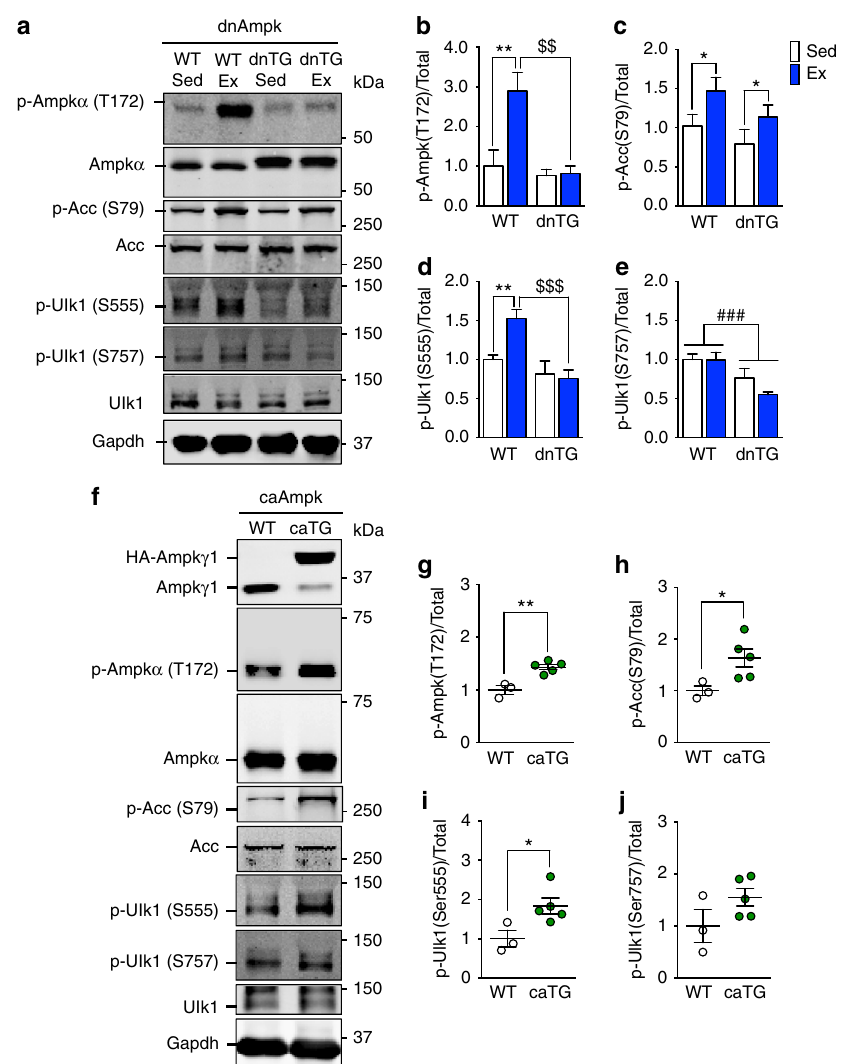
Fig. 3 Ampk is necessary and suf fi cient for phosphorylation of Ulk1 at Ser555 in response to acute exercise. Phosphorylation of Ampk at T172 in response to acute exercise is blocked in Ampk dnTG a , b , whereas increased phosphorylation of Acc at Ser79 post-exercise is still observed a , c . In Ampk caTG mice, both T172 Ampk and S79 Acc are elevated in sedentary conditions f – h . Phosphorylation of Ulk1 at Ser555 is blunted in dnTG skeletal muscle immediately after acute exercise a , d but elevated in caTG mice basally f , i . There was no effect on S757 phosphorylation in either dnTG mice post exercise a , e or sedentary caTG mice ( f , j ). Representative western blots are shown for dnTG mice a and caTG mice f . See also Supplementary Figs. 8 and 9. All quanti fi cation is presented as protein phosphorylation to total protein abundance ratio b – e , g – j . Data are presented as mean ± standard error of the mean. For dnTG study n = 10 WT or 5 – 7 dnTG (12 – 13 weeks). Results of two-way ANOVAs are * p < 0.05, ** p < 0.01 for sedentary vs. exercise comparisons, F = 4.57 and DF = 1 c . ### p < 0.001 for between group comparisons, F = 14.03 and DF = 1 ( e ). Tukey multiple comparison tests were performed when a signi fi cant interaction effect was observed, in which * p < 0.05, ** p < 0.01 for WT sedentary vs. WT exercise comparisons and $$ p < 0.01, $$$ p < 0.001 for WT exercise vs. dnTG exercise comparisons, DF = 27. For caTG study n = 3 (WT) or 5 (caTG) (13 – 15 weeks). Results of two-tailed t -tests are * p < 0.05 and ** p < 0.01 for WT to caTG comparisons, t = 4.94 ( g ), t = 2.57 ( h ), t = 2.71 ( i ), t = 1.72 ( j ), DF =